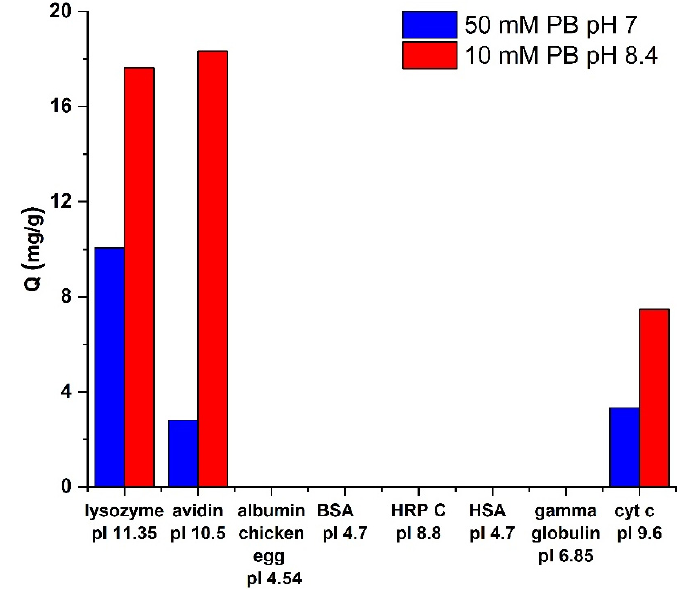
Figure 7. Selectivity of Lys-PMNPs towards other proteins at room temperature in different buffer systems. (1.6 mg/mL Lys-PMNP was incubated with 50 µg/mL protein solution in 50 mM PB, pH 7 or in 10 mM PB, pH 8.4).